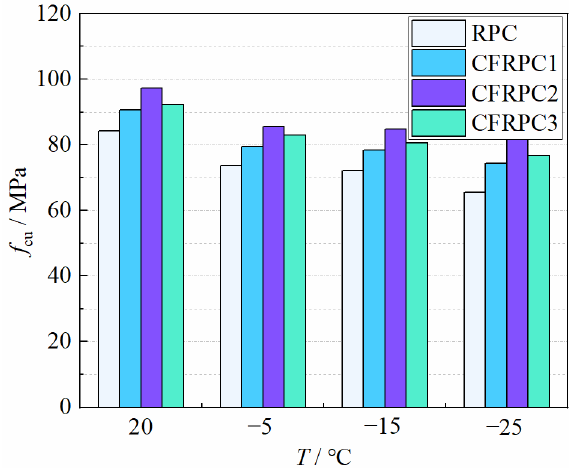
Figure 5. Relationship f cu vs. T.